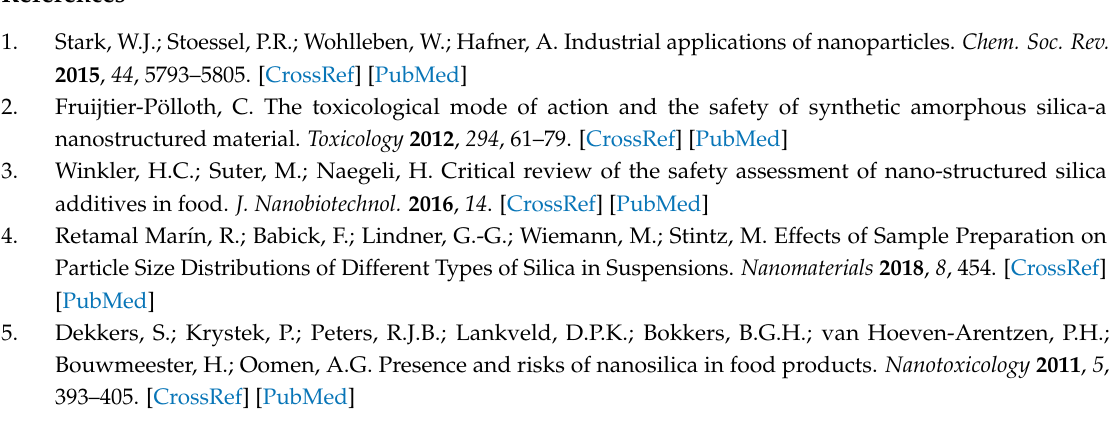
Figure S1: Size distribution of synthetic amorphous silica particles (SAS) after a 16 h incubation period in distilled H 2 O and F-12K medium, Figure S2: Correlation of SiO 2 nanoparticle-induced cytotoxicity of NR8383 macrophages with various surface